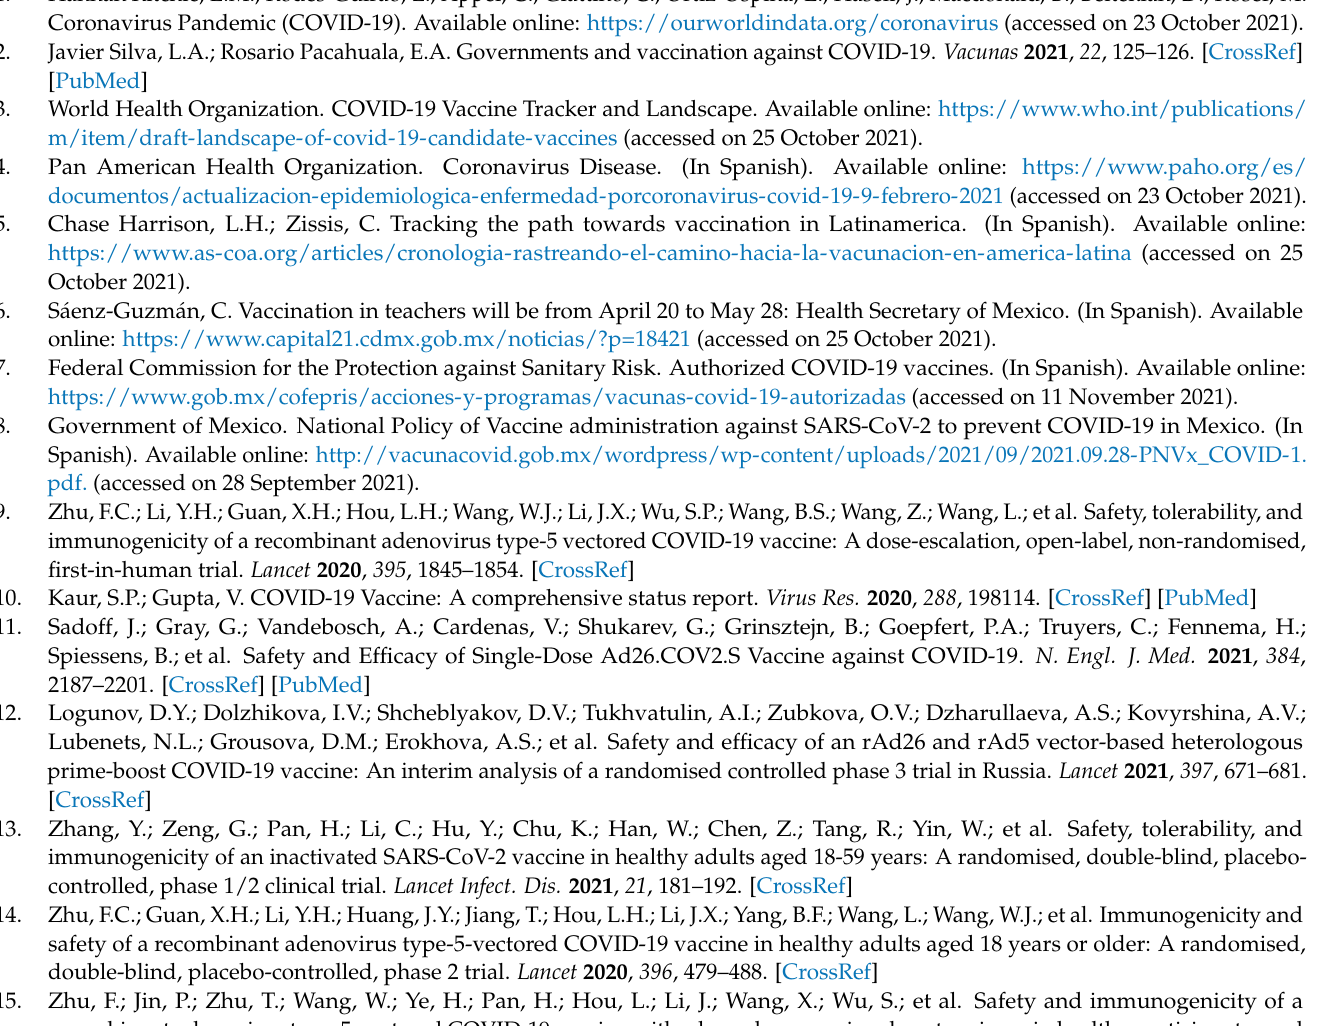
plicable. Table S4. Number of participants serologically tested and mean S antibody production according to administered vaccine and self-reported COVID-19